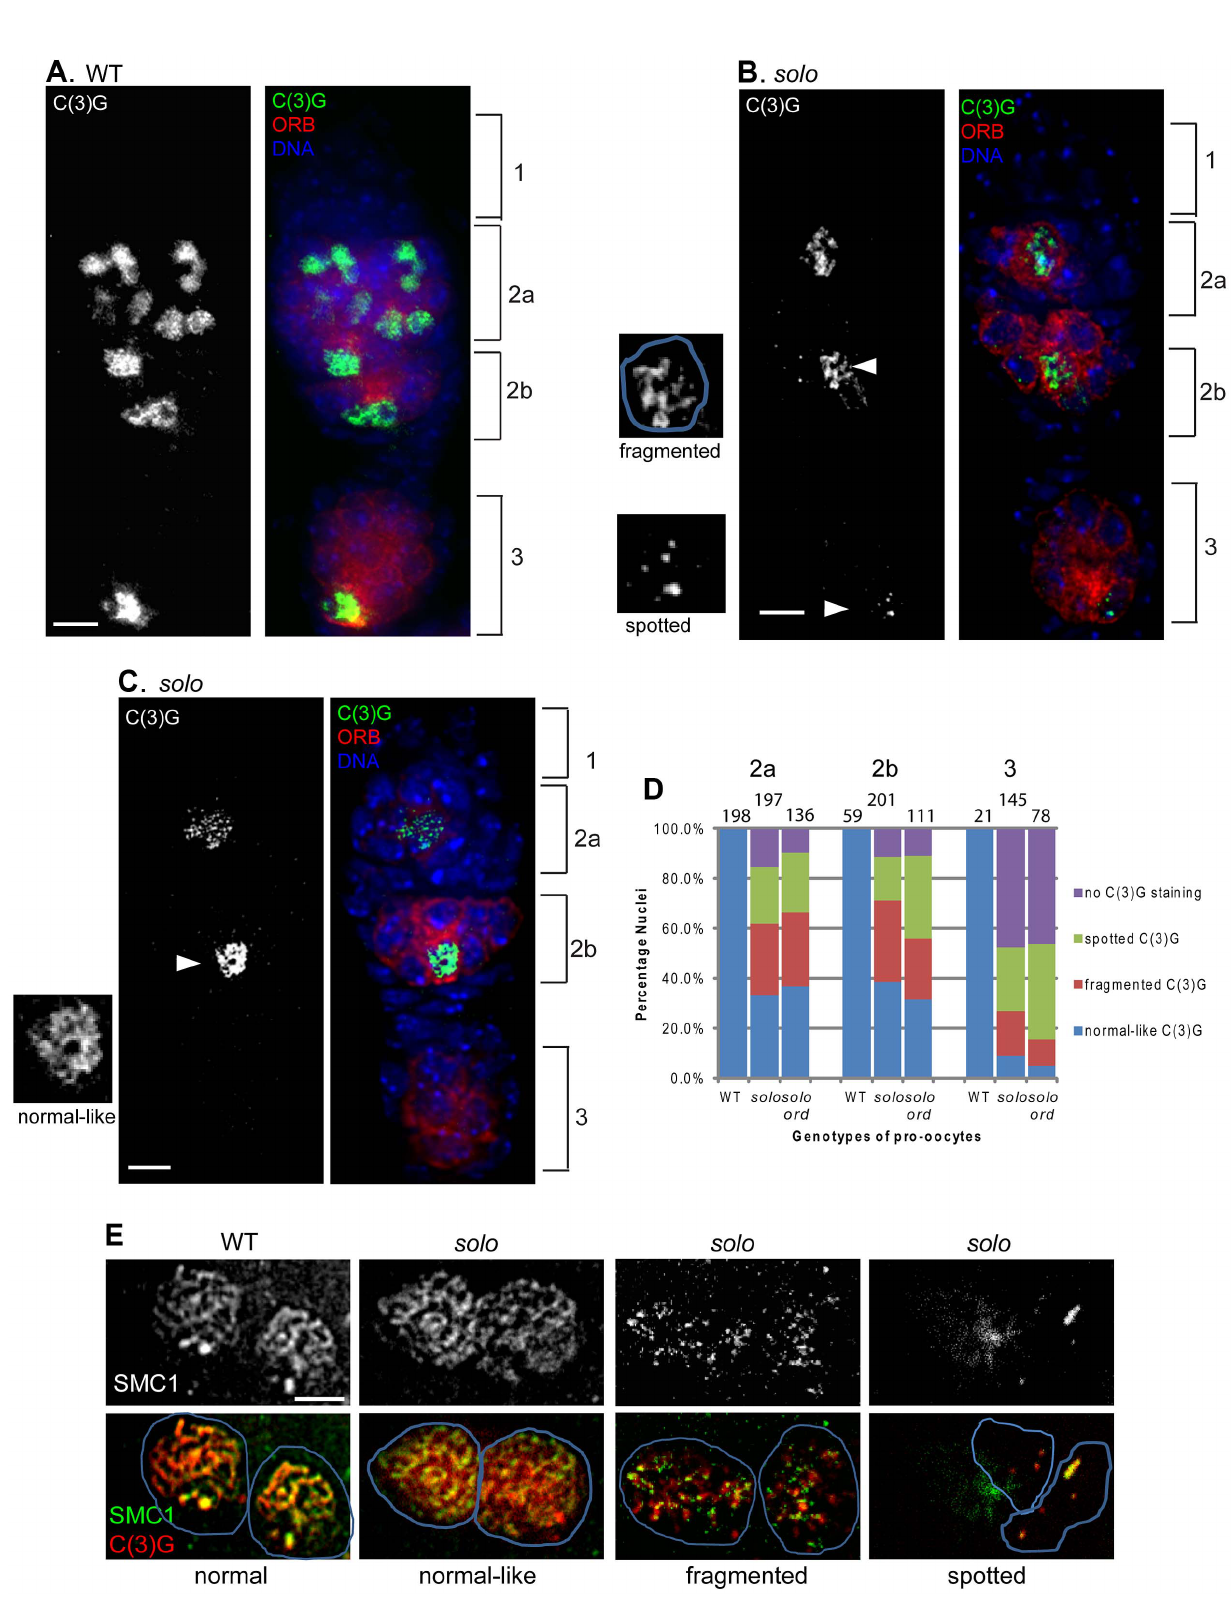
Figure 5. solo mutations destabilize lateral elements and central regions of SCs. Scale bar: 5 m m. (A–D) solo mutations caused defective C(3)G staining. Pro-oocytes and oocytes were stained by anti-ORB antibody. SC was visualized by anti-C(3)G staining and DNA was stained with DAPI. (A) In WT germaria C(3)G formed linear structures in nuclei of ORB-enriched cells within region 2a, 2b and 3, and was restricted to the oocyte in region 3. (B, C) In solo ( solo Z2-3534 / Df(2L)A267 ) germaria, pro-oocytes and oocytes were marked by enriched ORB staining. C(3)G staining patterns included spotted and fragmented (B) and normal-like (C) and are displayed in magnifications of cells marked with arrowheads. Note also the absence of C(3)G